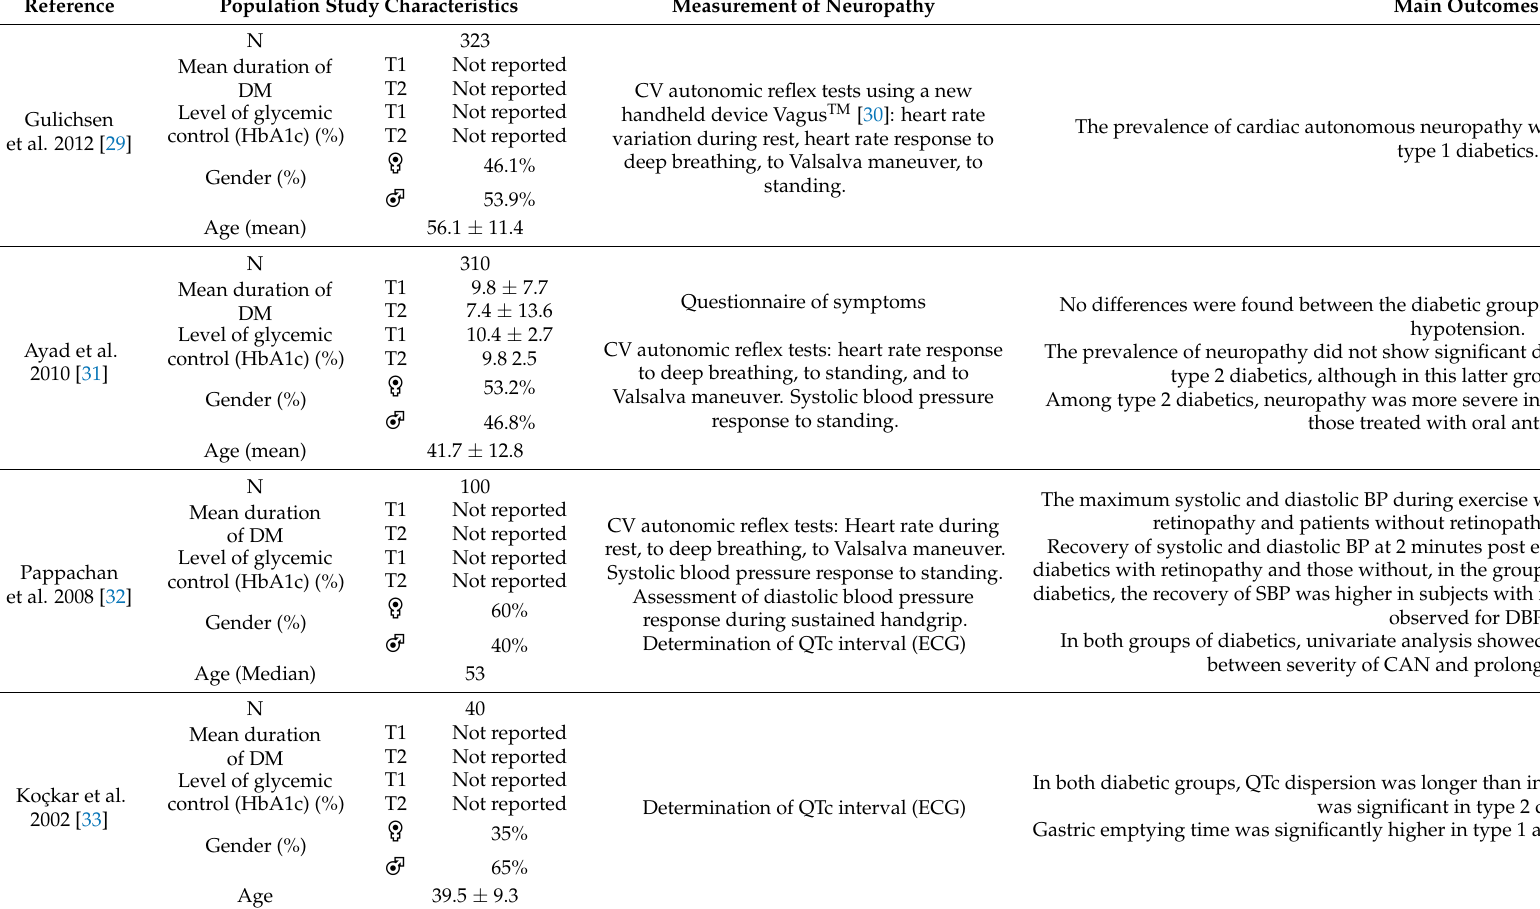
Table 1. Differences between type 1 (T1) and type 2 (T2) diabetes in sensory neuropathy. Figure 1. Systematic review workflow.